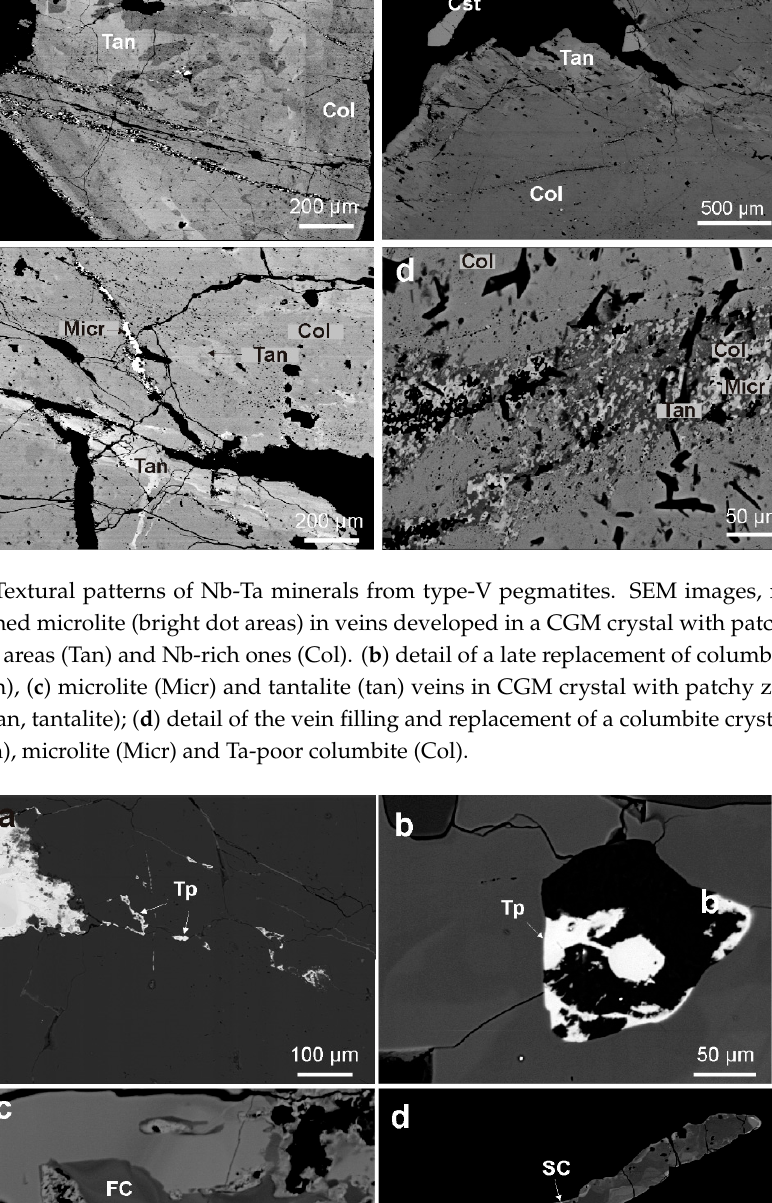
Figure 14. Textural patterns of tapiolite from type-IV pegmatites. ( a ) Tapiolite (Tp) filling fractures in quartz. ( b ) Tapiolite (Tp) filling a void in quartz produced by dissolution of a pre-existing mineral. ( c , d ) Replacement of columbite-(Fe) (FC) by tapiolite (TP) and stibiocolumbite (SC).